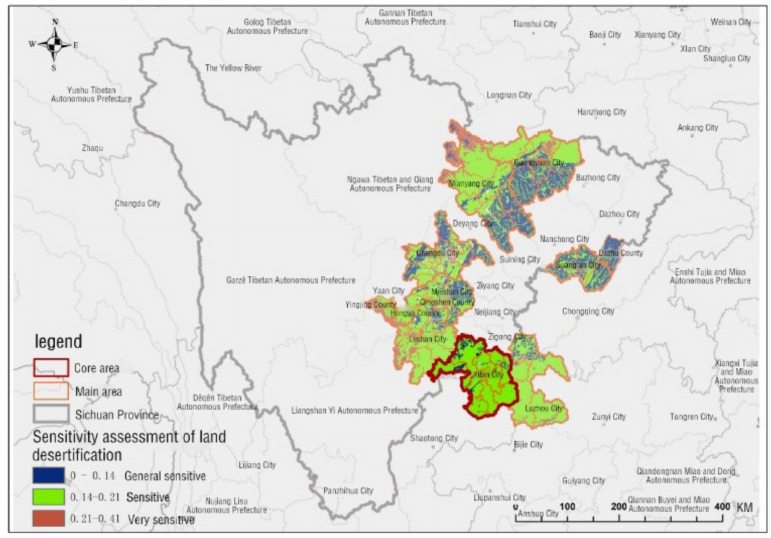
Figure 15. Land desertification sensitivity analysis of research areas in Sichuan Province.